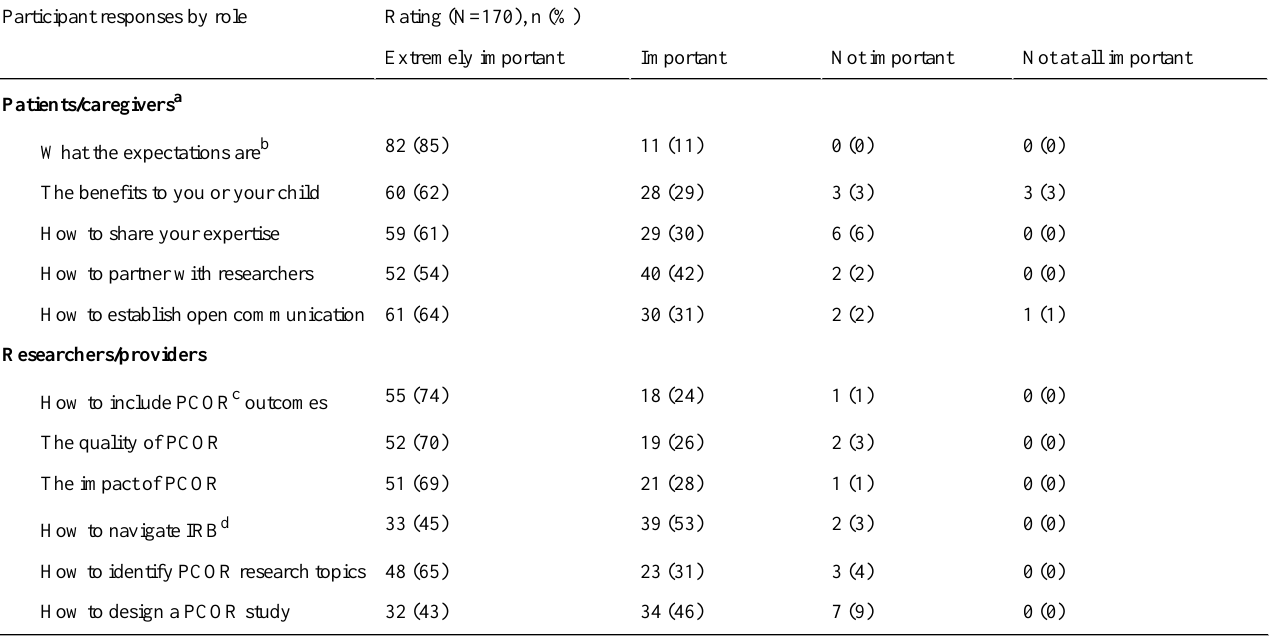
Table 2. Participant ratings of what to learn before engaging in patient-centered outcomes research.